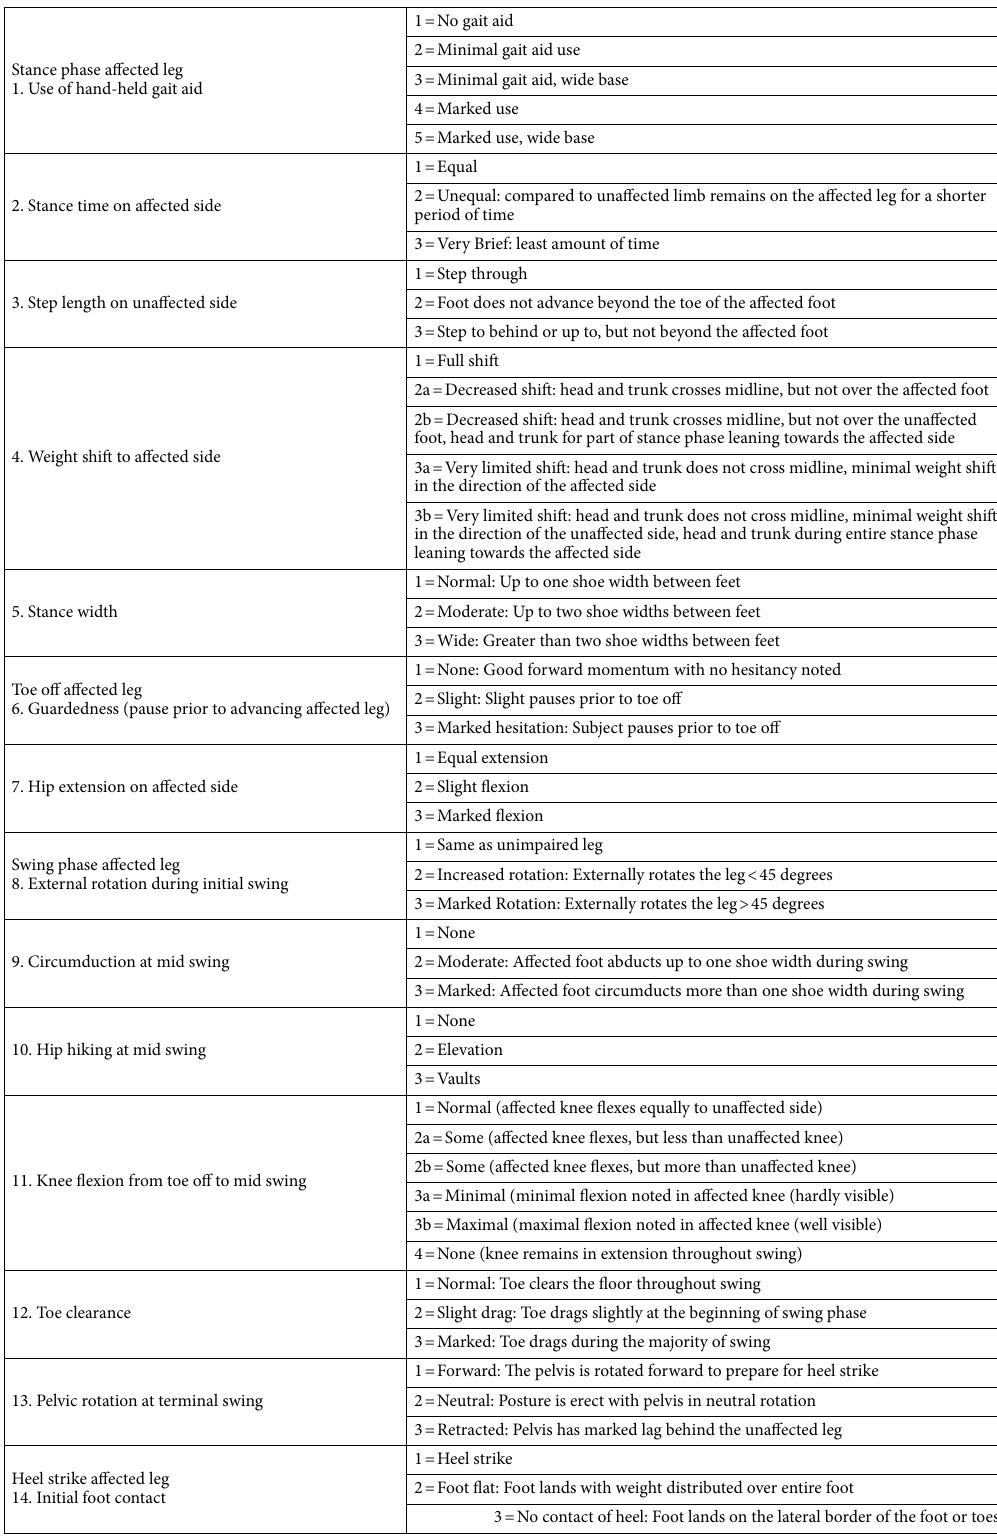
Table 2. Items of computerised paediatric